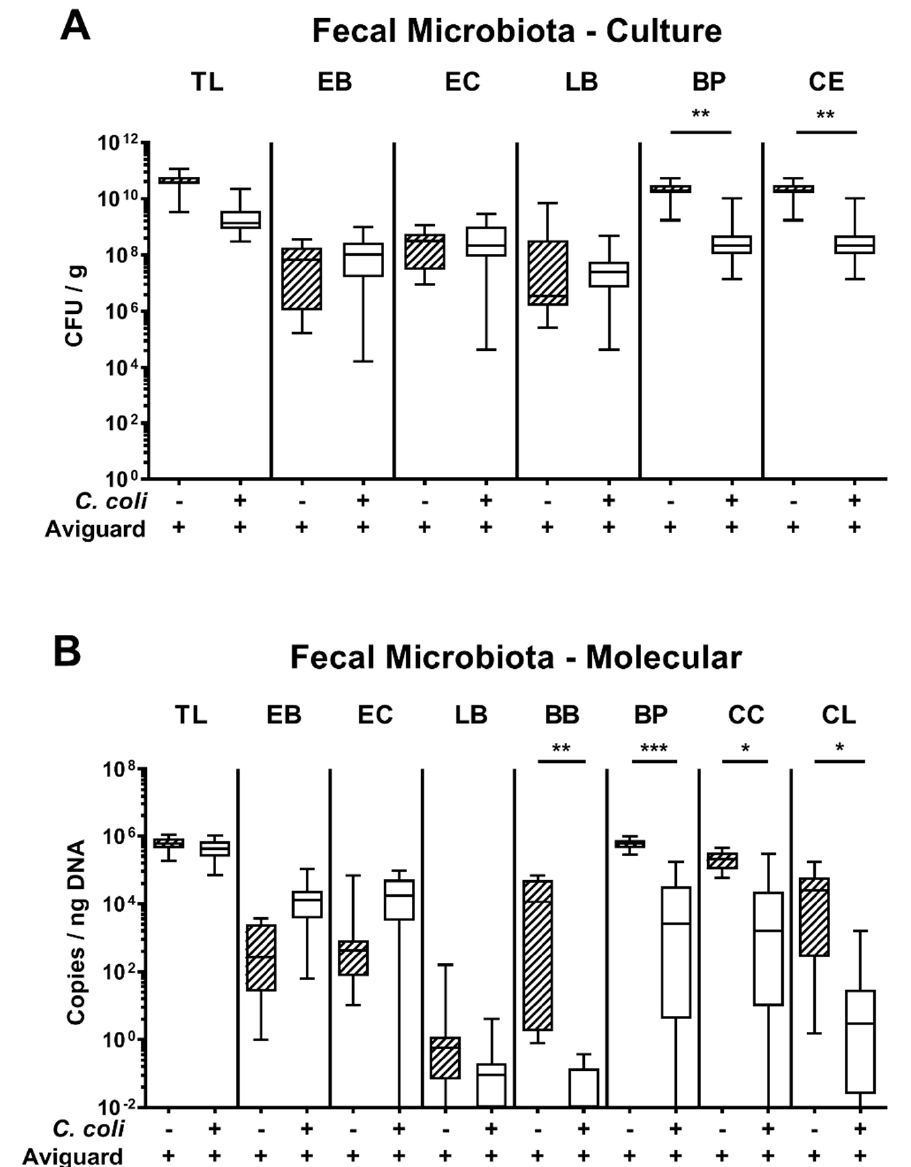
Figure 3. Comprehensive analysis of the gut microbiota composition following peroral Aviguard ® treatment of C. coli -infected secondary abiotic IL-10 − / − mice. Mice were infected with a C. coli patient isolate on the day (d) 0 and d1 by gavage and perorally challenged with the probiotic formulation Aviguard ® ( n = 17) on d2, d3 and d4 post-infection (p.i.). On d6 p.i., the fecal microbiota composition was quantitatively surveyed by ( A ) culture (expressed as colony-forming units per g, CFU/g) and by ( B ) molecular (i.e., 16S rRNA based) methods (expressed as copies / ng DNA). Aviguard ® treated non-infected mice served as controls ( n = 10). The box plots indicate the 25th and 75th percentiles of the medians (bar within boxes). Total range and significance levels ( p values) calculated by the Mann–Whitney U test are given. Shown data were derived from three independent experiments. TL, total bacterial load; EB, Enterobacteriaceae; EC, Enterococcus genus; LB, Lactobacillus species; BP, Bacteroides/Prevotella genus; CE, Clostridium/Eubacterium species; BB, Bifidobacterium genus; CC, Clostridium coccoides group; CL, Clostridium leptum group.* p < 0.05; ** p < 0.01; *** p < 0.001. +, with; − ,